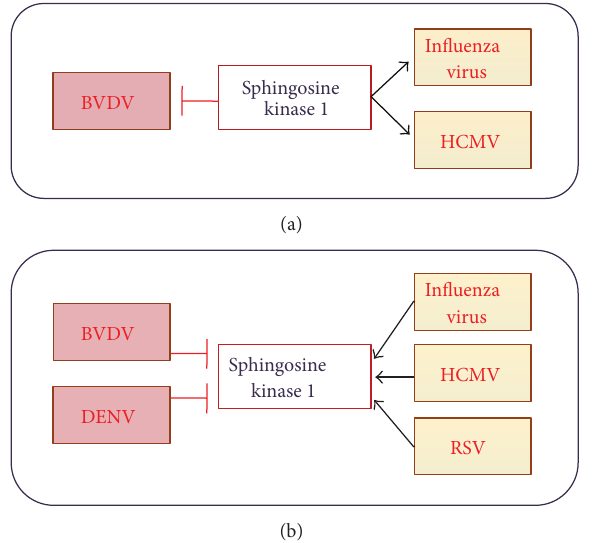
Figure 5: Interaction between SK1 and viruses. (a) SK1 inhibits BVDV replication, whereas SK1 heightens cellular susceptibility to the infection with influenza virus or HCMV. (b) BVDV and DENV decrease SK1 expression/activation, whereas influenza virus, HCMV, and RSV increase SK1 level/activation.